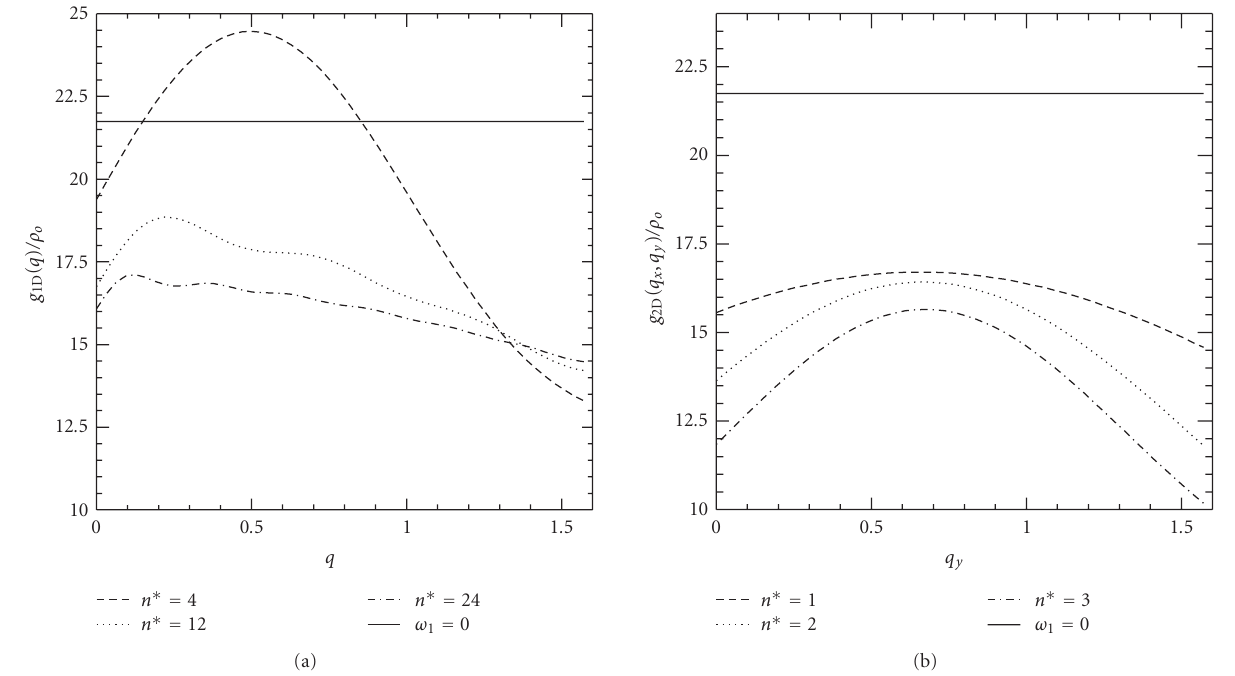
Figure 4: (a) Time averaged e-ph coupling (in units meV ˚A − 1 versus wave vector for a linear chain. n ∗ represents the cuto ff on the e-ph correlations. ρ 0 is the electron density. ω 0 = 20meV and ω 1 = 10meV. g = 3. The dispersionless e-ph coupling is obtained for ω 1 = 0. (b) Time averaged e-ph coupling in two dimensions versus the y component of the momentum. The cases n ∗ = 1, n ∗ = 2, and n ∗ = 3 imply that the correlation range includes the second, the fifth and the ninth neighbors shell, respectively. The input parameters are as in (a).